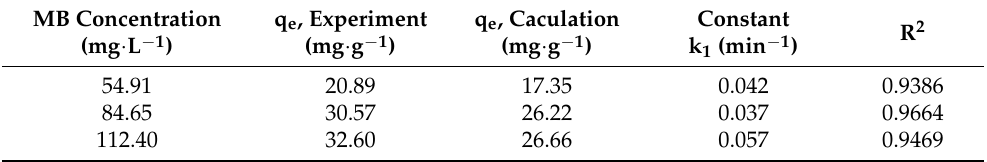
Table 6. Parameter values of pseudo-first-order adsorption kinetics equation.